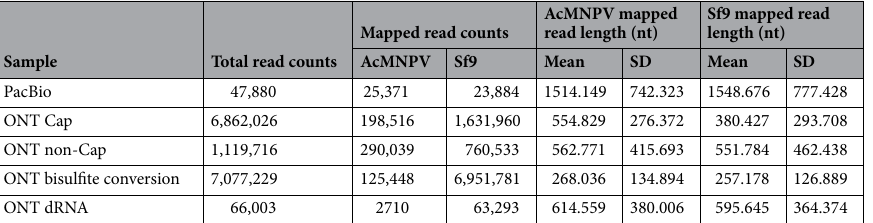
nts surrounding of the viral TESs was characterized by A/U-rich sequences with an increased adenine content immediately upstream of the cleavage site. Intriguingly, sequences harboring a PAS showed a slight increase of